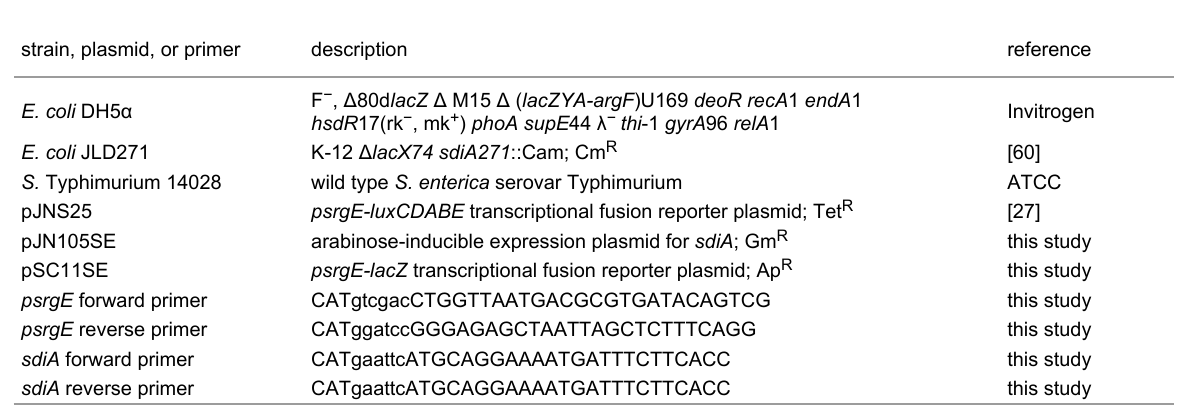
strain, plasmid, or